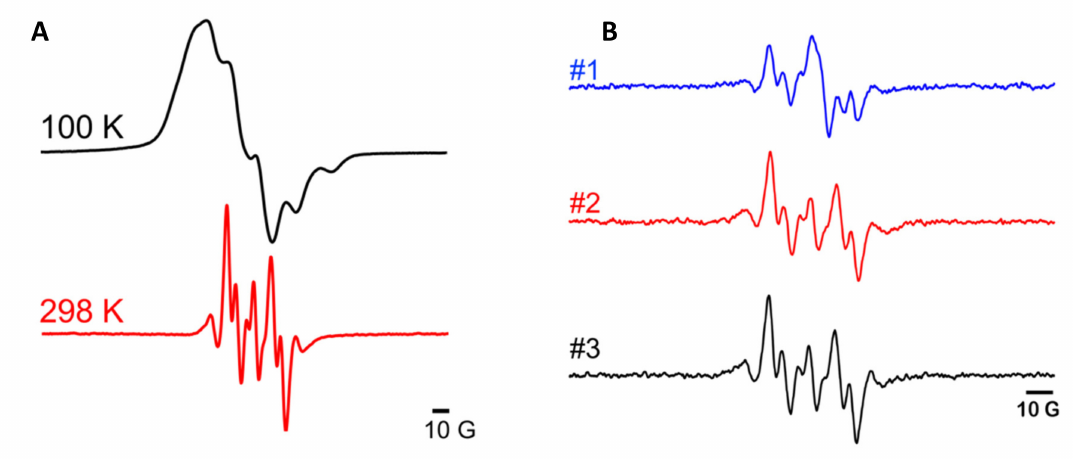
Figure 5. ( A ): Continuous wave (CW) EPR X-band (9.5 GHz) spectra of 10 mM AMUPol in a sample containing 5.5 / 2.7 / 2 / 1 DPPC-d 62 / DPPC / POPG / cholesterol liposomes with 2 mol% KL 4 peptide. EPR spectra shown in red and black were collected at 298 K and 100 K, respectively. ( B ): EPR spectra at 298 K for three liposome preparations containing 10 mM AMUPol prepared in